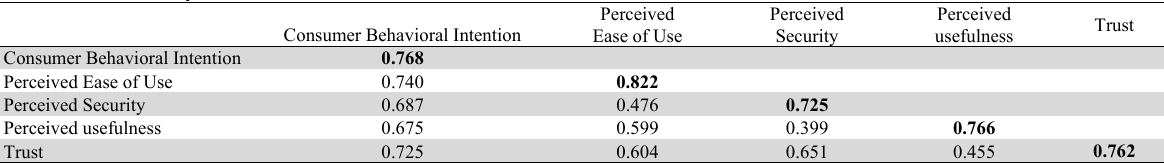
Discriminant Validity